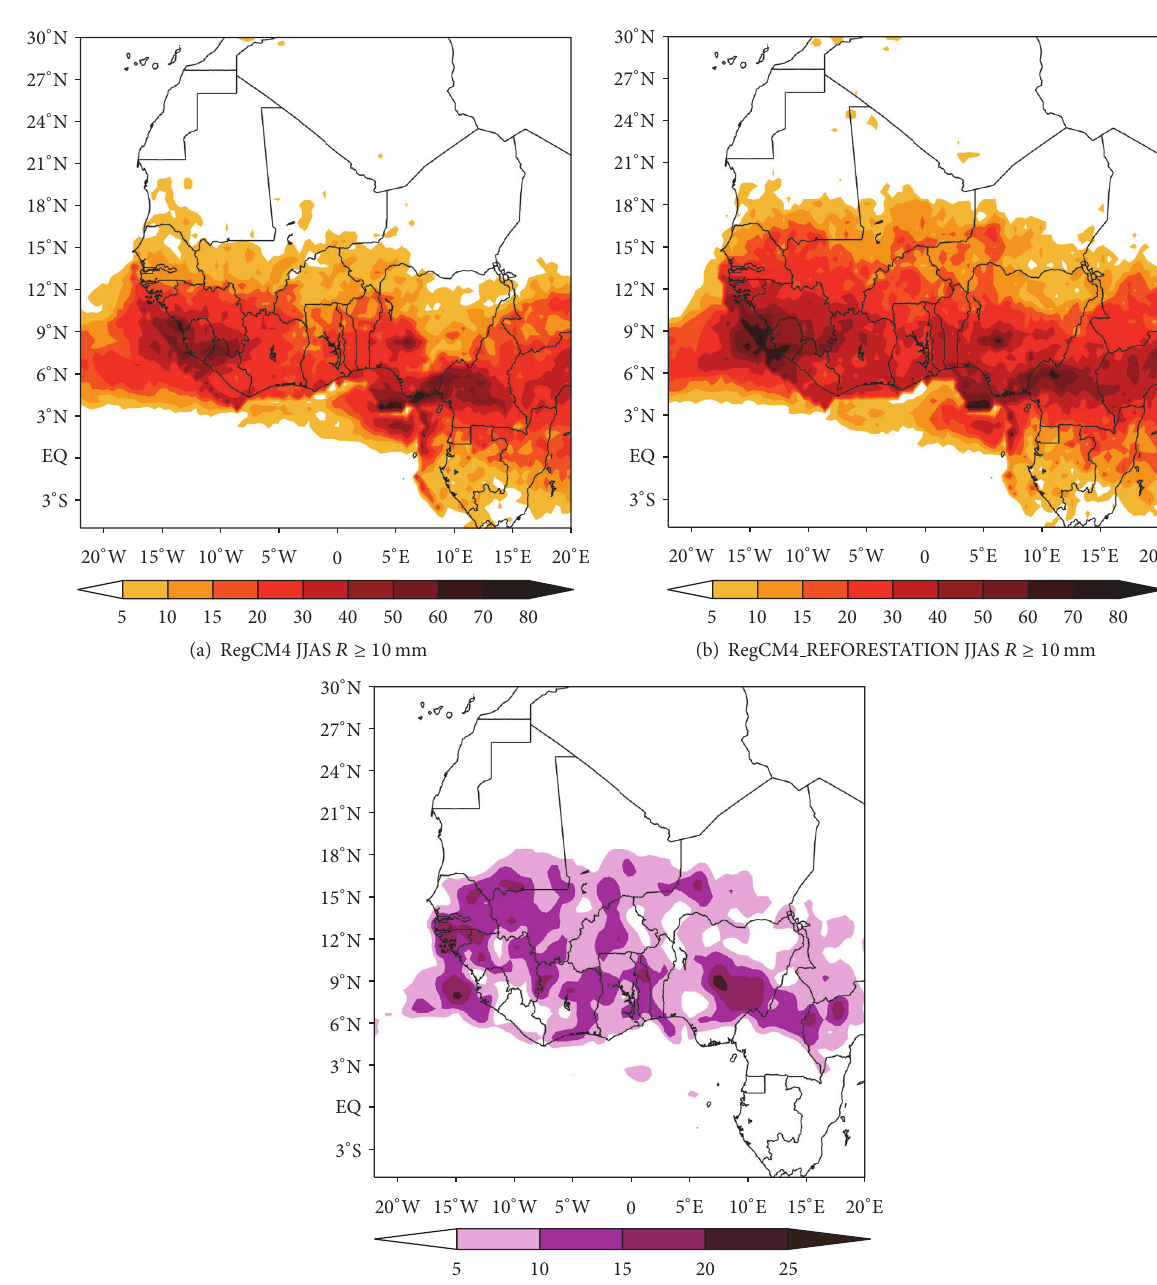
Figure 10: Mean summer frequency of intense rainfall days ( 𝑅 ≥ 10 mm) for both runs and their difference averaged from 2003 to 2009.